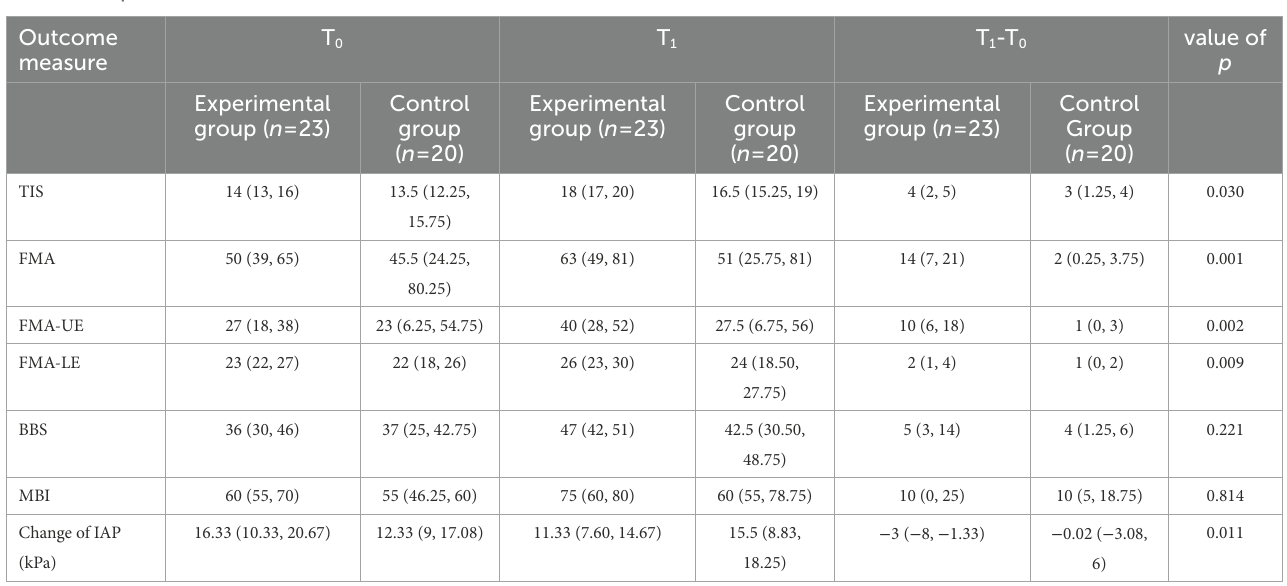
TABLE 2 Comparison of TIS, FMA, FMA-UE, FMA-LE, BBS,